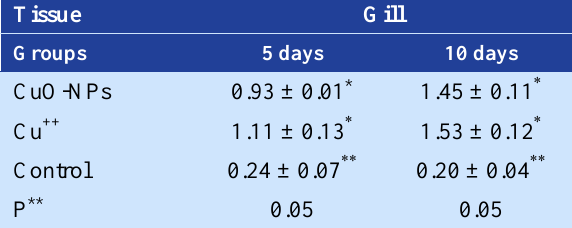
Table 1. Copper accumulation in the gill of guppy following 5 or 10 days exposure